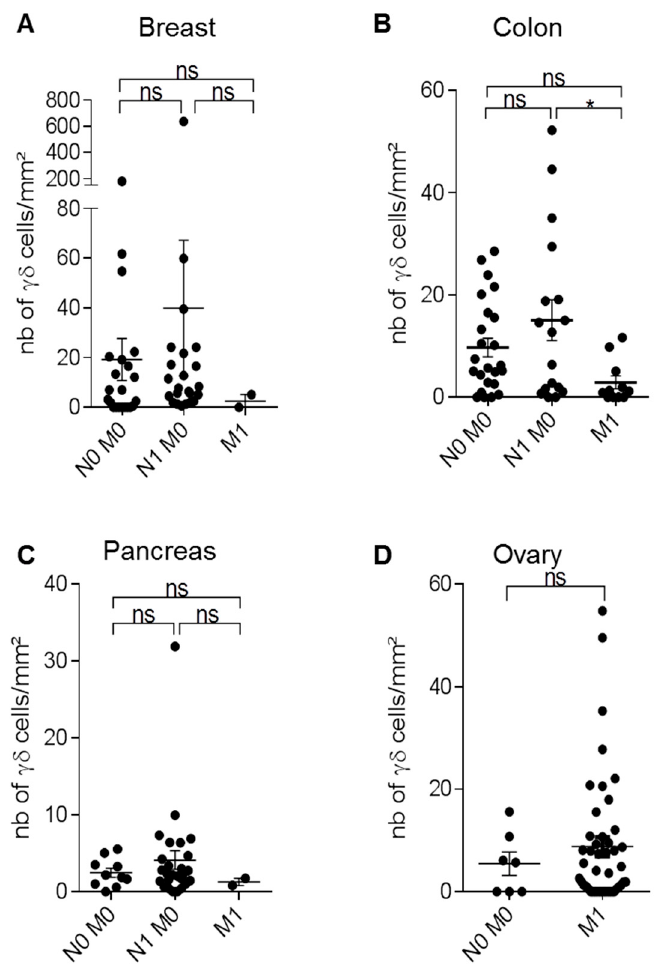
Figure 7. Analysis of γδ T-cell density in function of the tumor, node, and metastasis (TNM) classification. Immunohistochemical detection of γδ T-cells in breast, colon, pancreatic, and ovarian tumors in chemotherapy-naïve patients. Scatter plots comparing γδ T-cell density in N0 M0, N1 M0, and M1 breast ( A ), colon ( B ), pancreatic ( C ), and ovarian ( D ) tumors. Data are the mean ± SEM. Ns: non-significant; * p < 0.05 (Kruskal–Wallis with Dunn’s multiple comparison test).